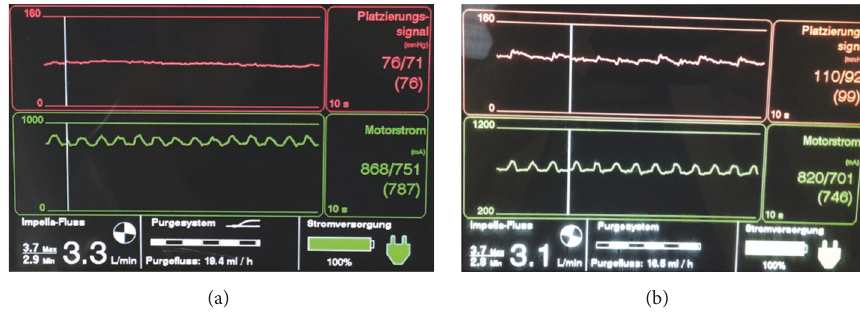
Figure 3: Impella CP Monitor. Impella CP Monitor at initial stage (a); Impella CP Monitor at advanced stage (b).